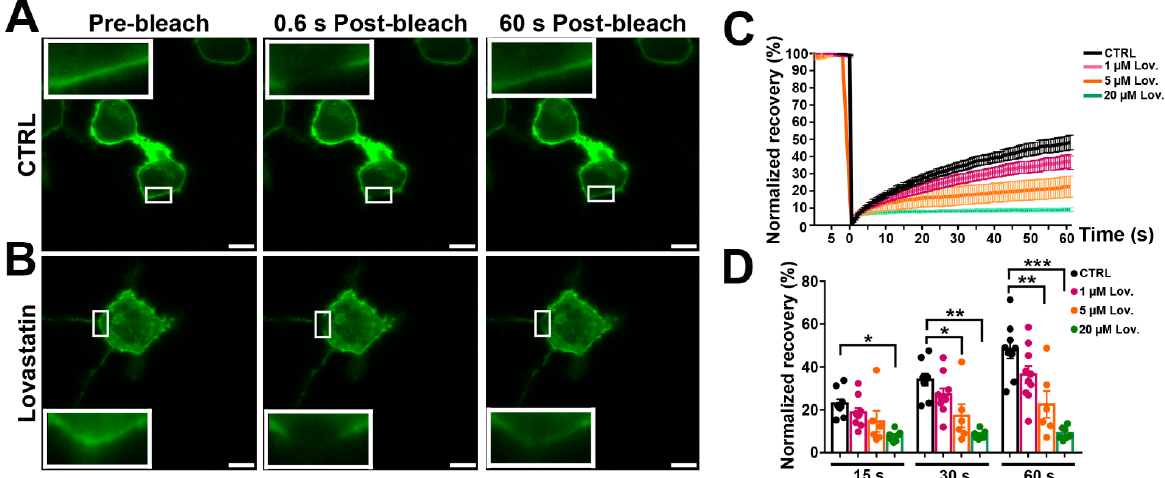
Figure 6. Cholesterol depletion by lovastatin impairs lateral mobility of mPanx1-GFP. ( A ) Fluores- cence micrographs of N2a cells transiently transfected with mPanx1-GFP showing FRAP results before and after FRAP in normal medium and ( B ) after 12 h treatment with 5 µM lovastatin. Bars: 10 µm; insets in each panel are higher magnification of FRAP area (3×). ( C ) FRAP recovery curves obtained after treatment with 1, 5, and 20 µM lovastatin. ( D ) Normalized FRAP recovery at 15, 30, and 60 s after photobleach. p values obtained from ANOVA followed by Dunnett’s test. Each curve represents the average from 7 to 10 cells. Data collected over four independent repeats. Error bars are SEM. * p < 0.05, ** p < 0.01, *** p < 0.001.